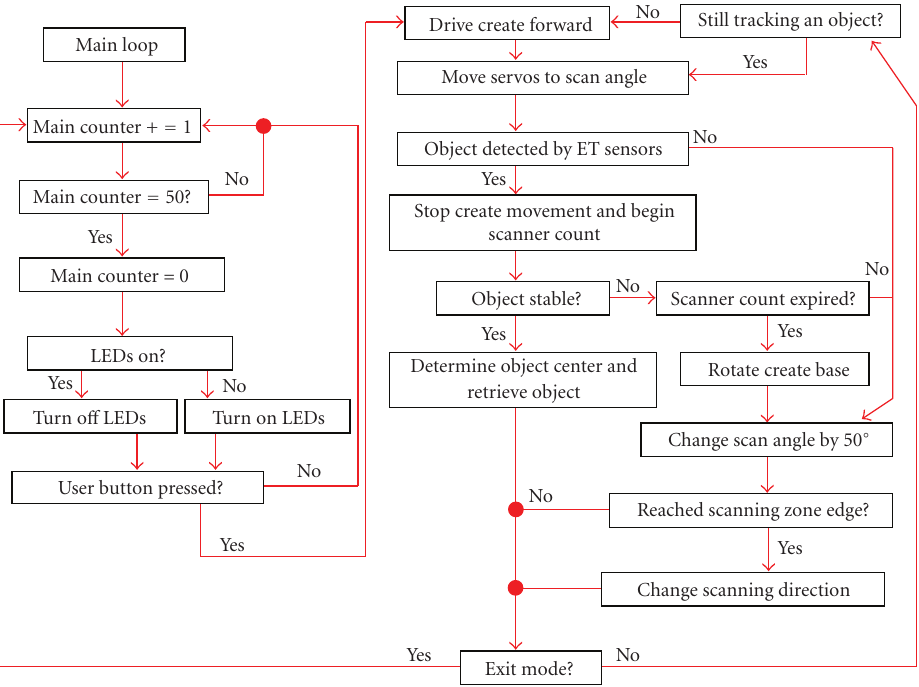
Figure 15: Main loop program flow chart.